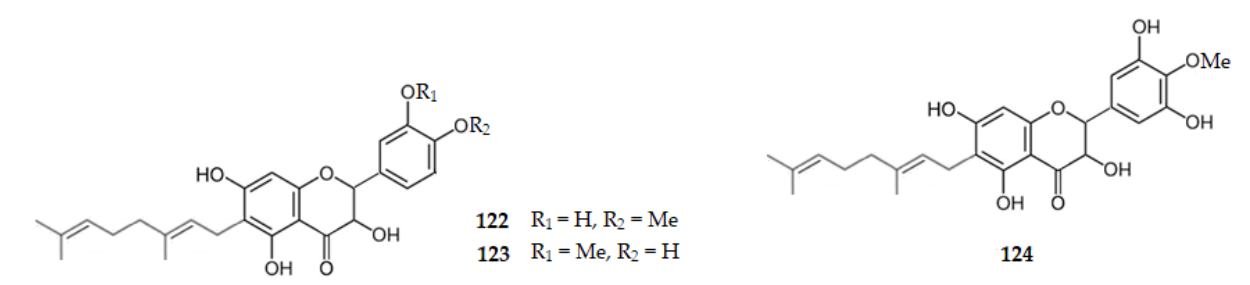
Figure 12. Structure of the AChE inhibitors 3-hydroxyflavanones 123 – 125 .